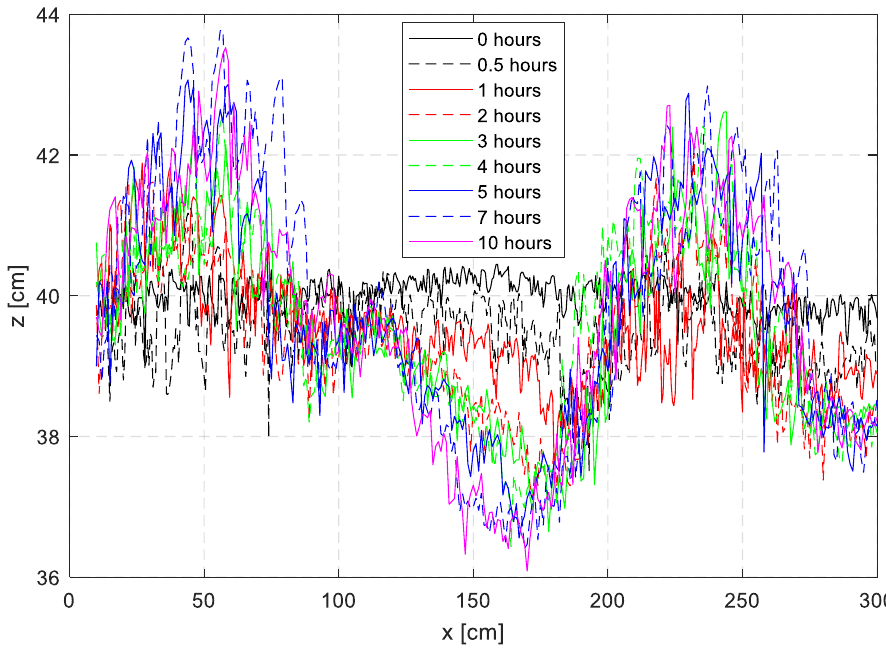
Figure 5. Bottom evolution over time: the generation of a sand wave.